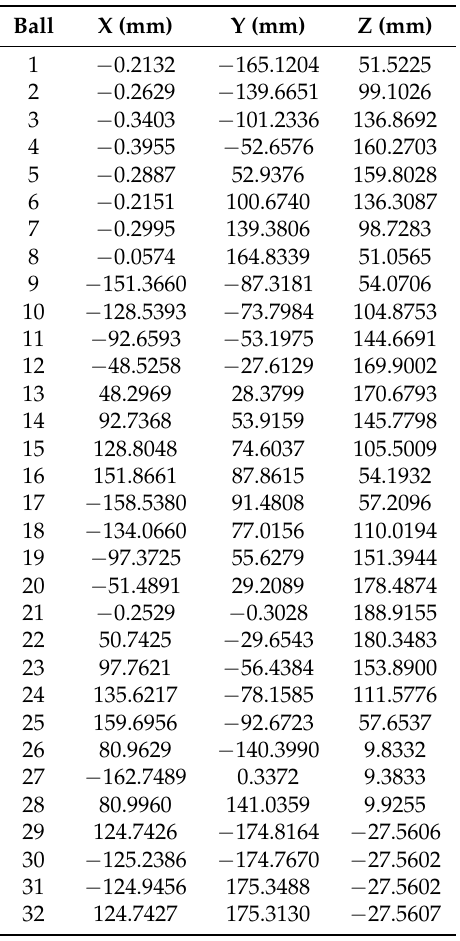
Table 3. Balls coordinates measured on the coordinate measuring machine (CMM) and used as calibrated